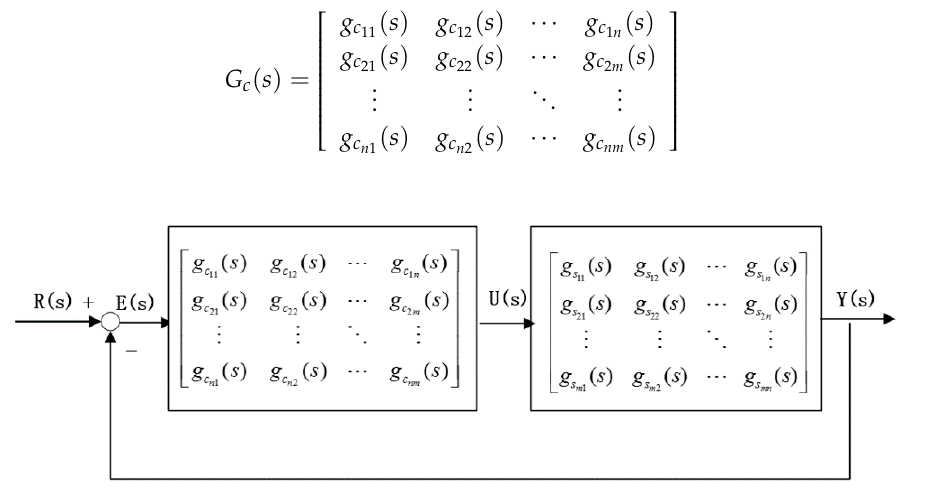
Figure 4. Closed-loop control schematic diagram of a multivariable non-square